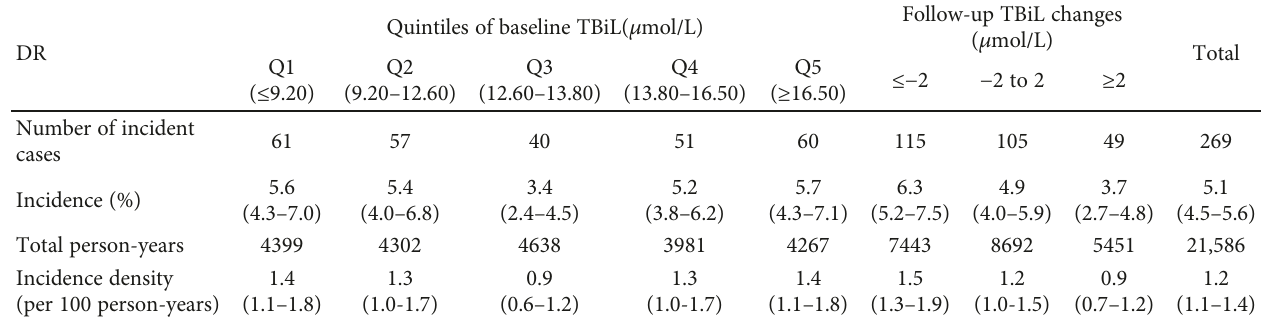
Table 2: Incidence of DR according to baseline TBiL quintiles and follow-up TBiL changes.